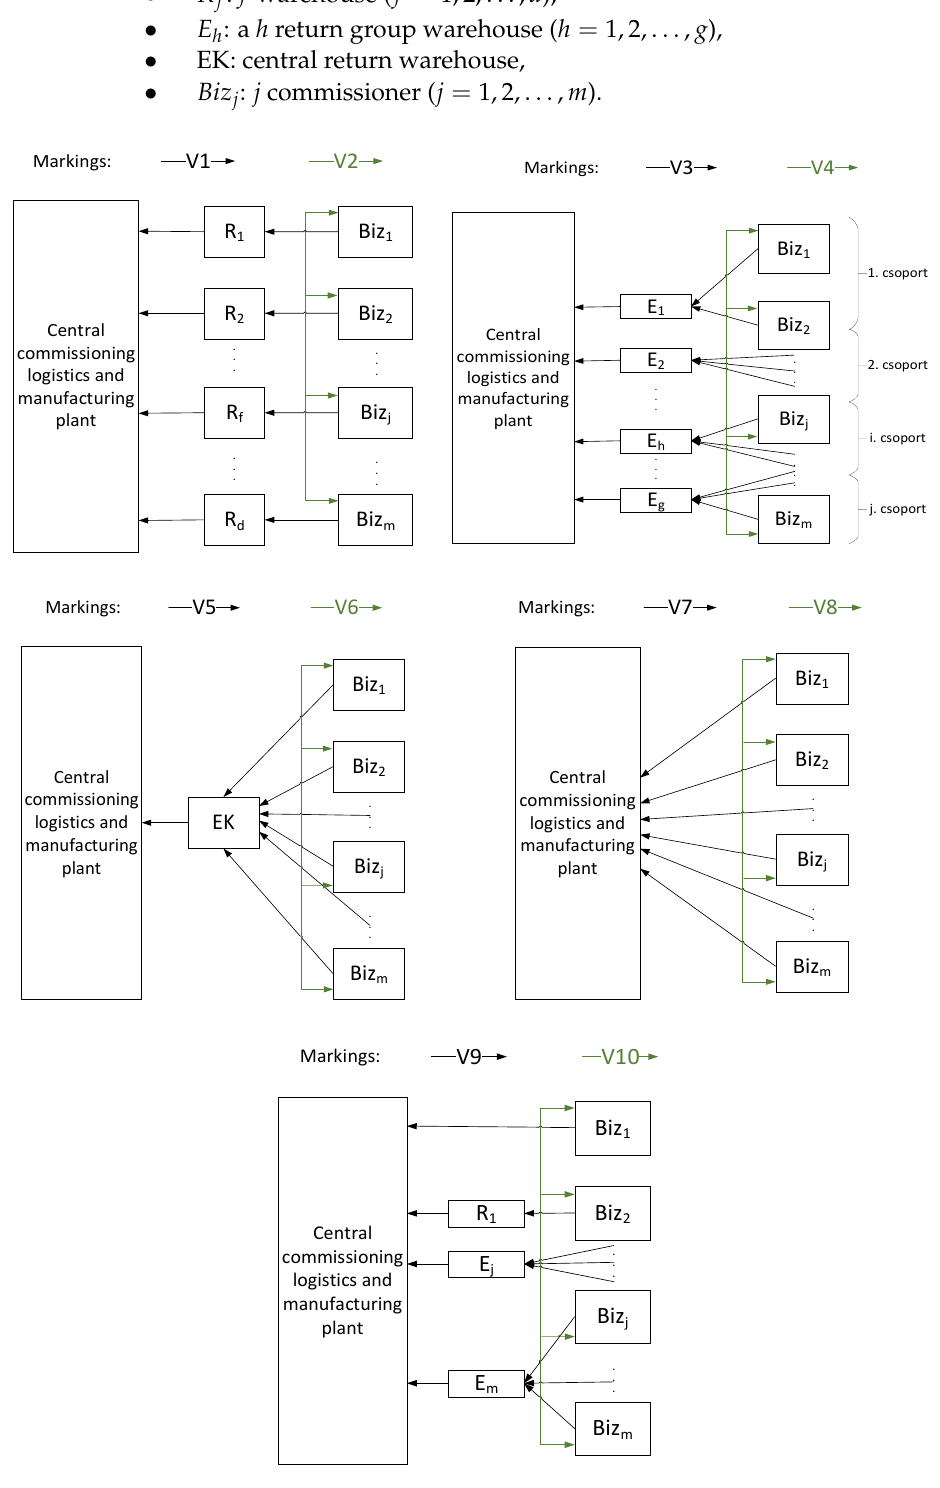
Figure 5. Return model variants (Source: Self-Edit).